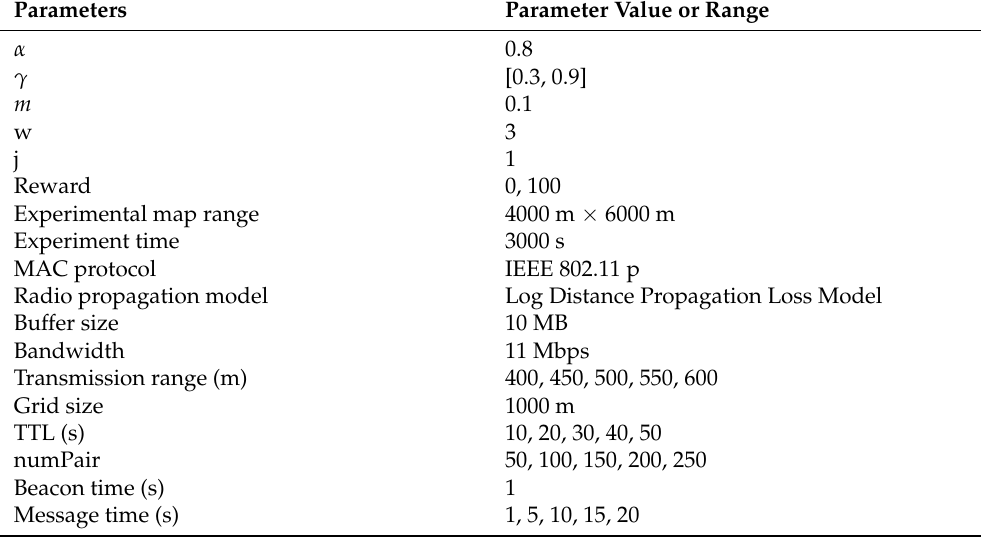
Table 8. Simulation